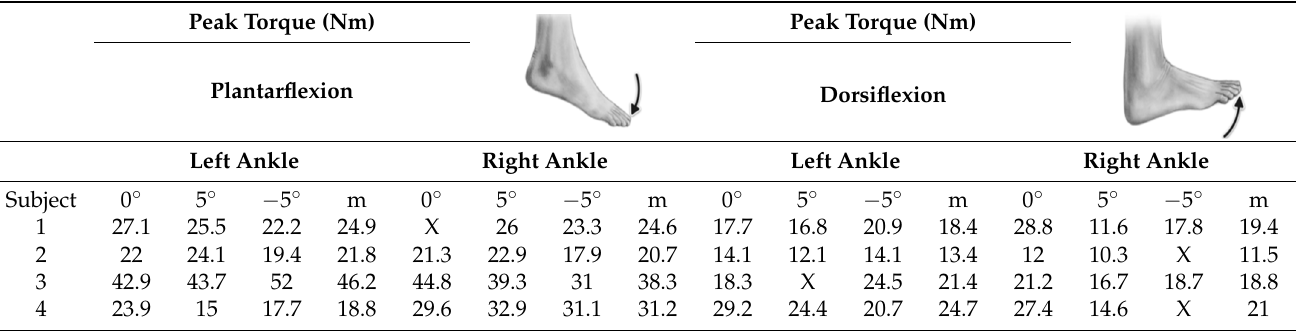
Table 2. Individual participant data showing peak torque (Nm) during MIVC for both plantarflexion and dorsiflexion for four participants at 0°, +5° and − 5°. Peak Torque (Nm)